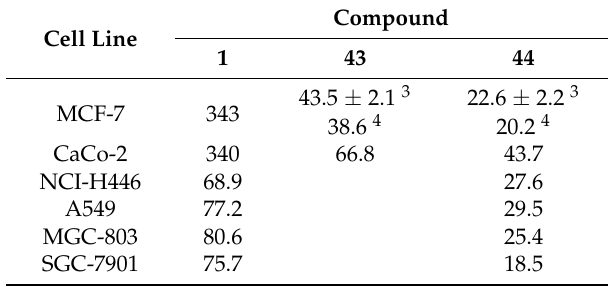
Table 4. Cytotoxicity data of compounds 43 and 44 compared to quercetin 1,2 .